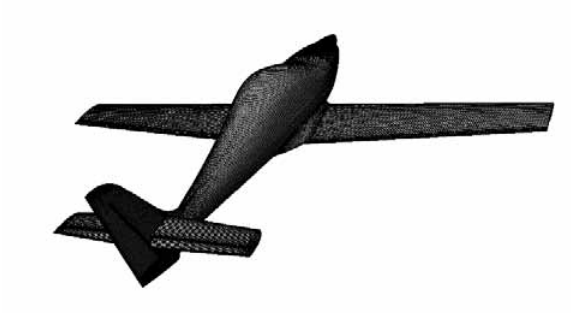
Fig. 3. Computational